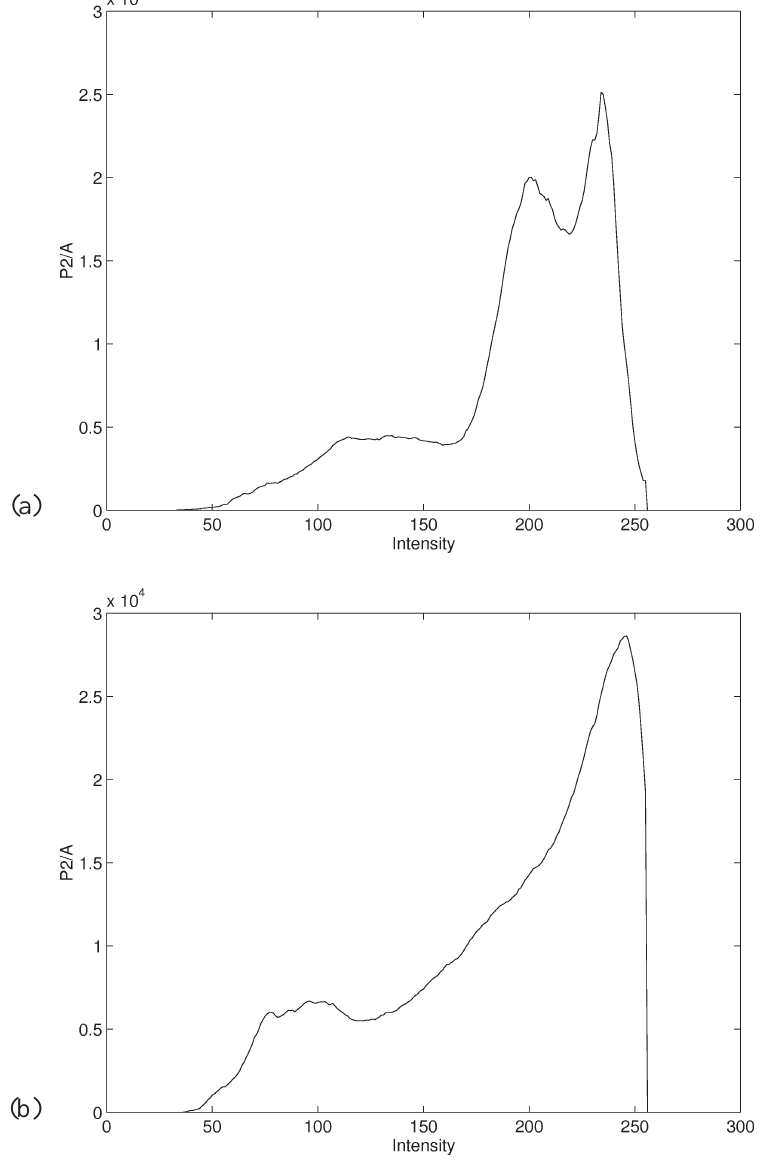
Fig. 3. P 2 / A -histograms ( P 2 / A -values on the y -axis) of the images in Fig. 1. (a) has two significant peaks, but (b) has only one significant